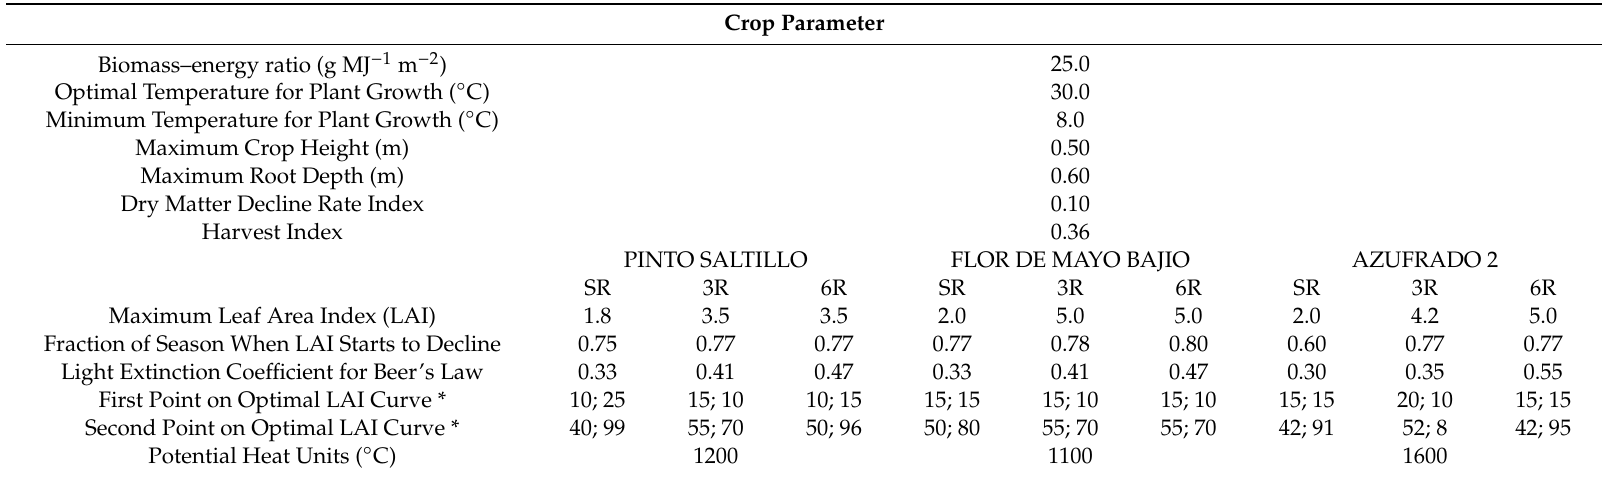
Table 3. Crop parameters for common bean cultivars growth habit III Flor de Mayo Bajio and Pinto Saltillo and growth habit I Azufrado 2 sown at seed densities of 90,000 (SR), 145,000 (3R), and 260,000 (6R) plants ha − 1 under rainfed conditions in Mexican semi-arid temperate